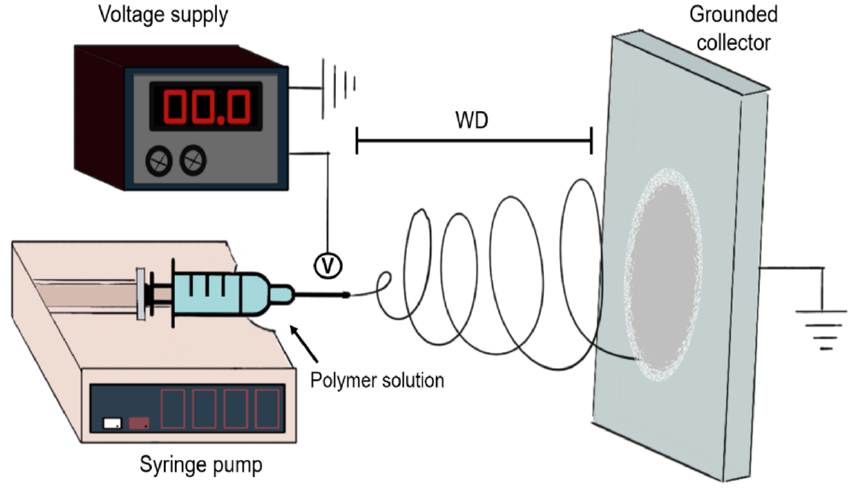
Figure 4. Diagram of the fabrication of nano/microfibers using a conventional electrospinning setup. First, a polymer solution is a pump through a capillary, commonly using a syringe pump. Then the working distance (WD) is set. The high voltage source with positive polarity is connected to the capillary and negative polarity connected to a grounded collector. As the polymer solution flows through the tip of the capillary it forms a jet that travels towards the collector.